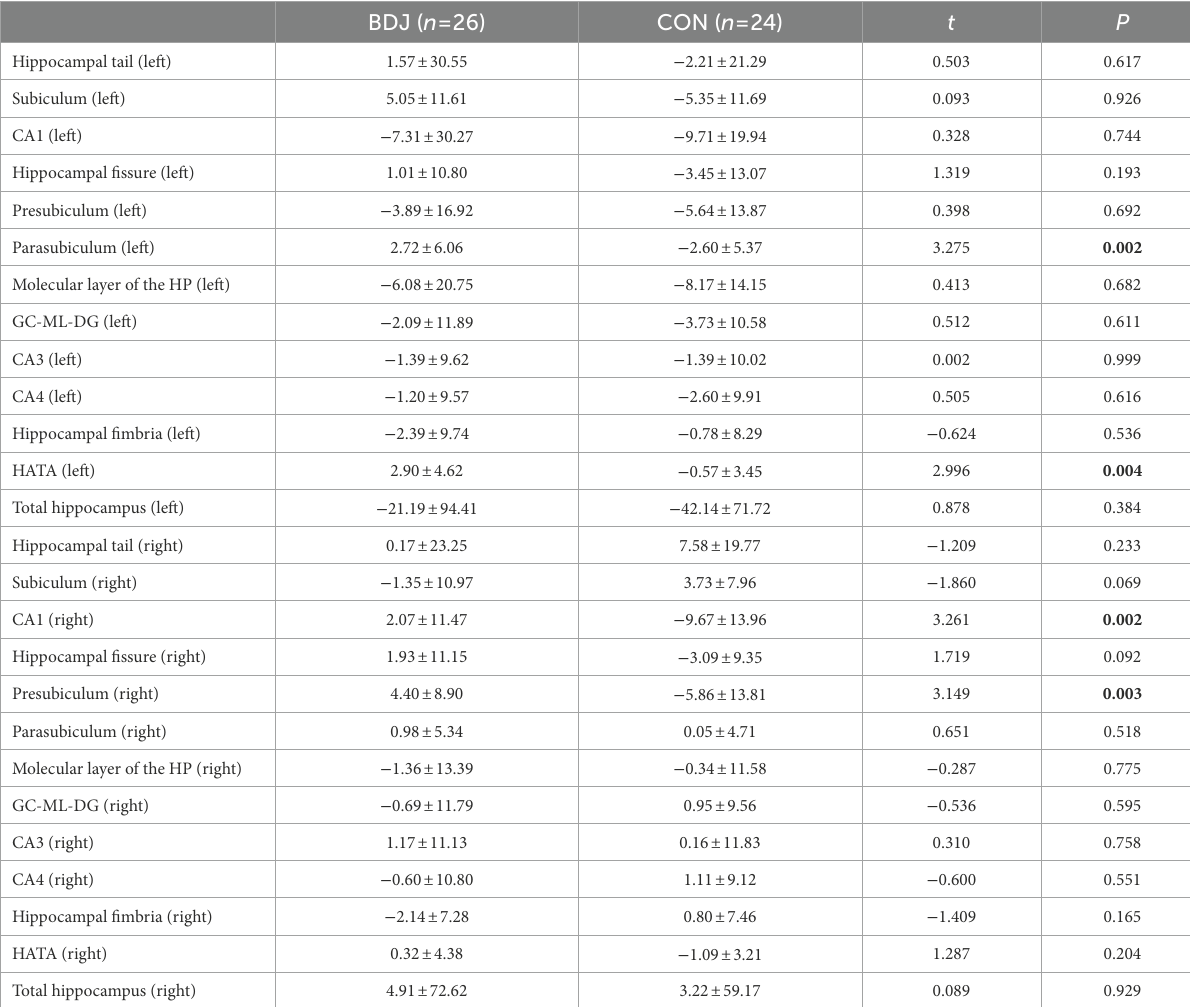
TABLE 4 Comparison of the volume change between the two groups (unit: mm 3 ). BDJ ( n = 26) CON ( n = 24) t